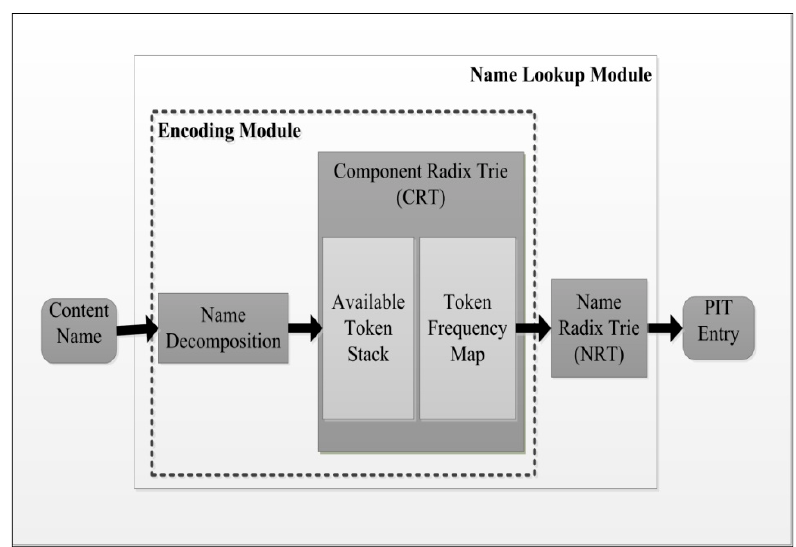
Figure4. Framework of Radient design. Figure 4. Framework of Radient